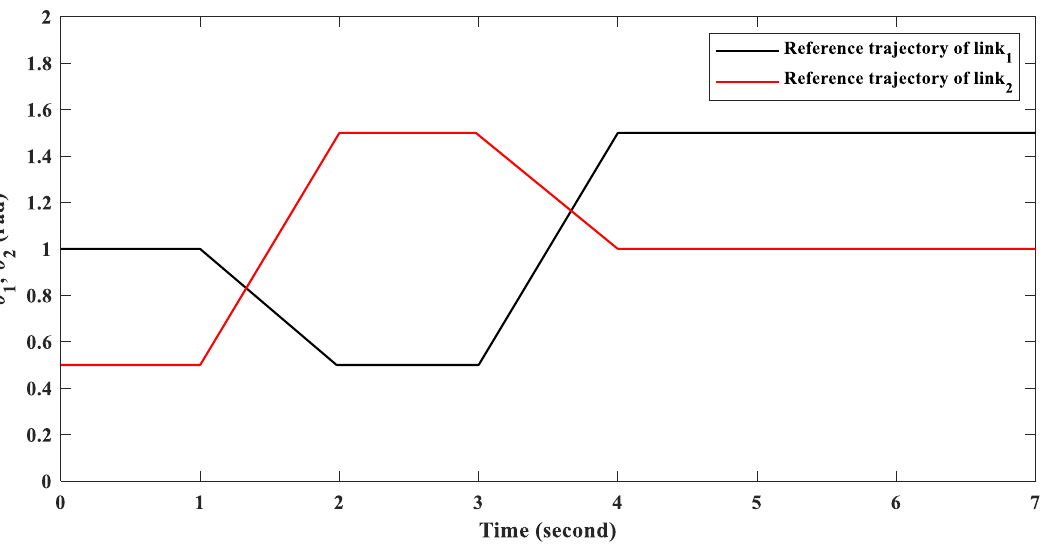
Figure 13. Random step-position trajectories of the two links.